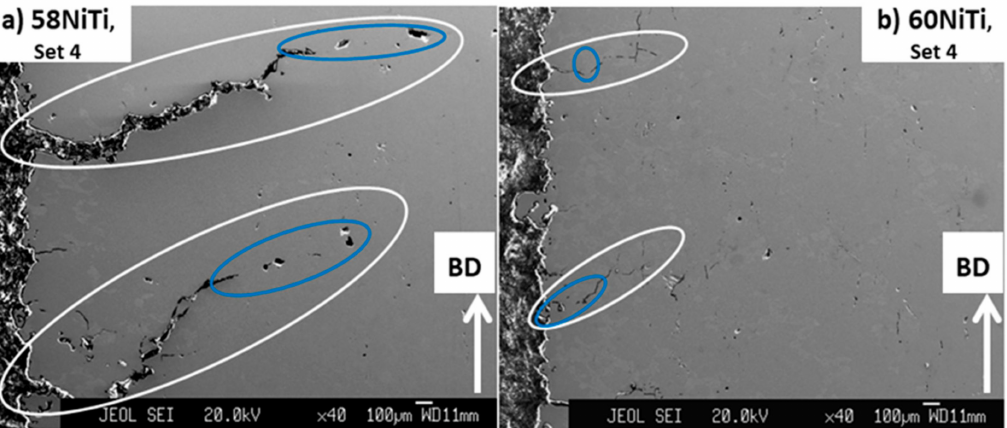
Figure 10. Images obtained from the cross-section of ( a ) 58NiTi and ( b ) 60NiTi parts processed from parts printed by processing set 4 having an energy input of 39.68 J/mm 3 . The white ovals show the total length of cracks, and the blue ones show the areas where the cracks were thought to be closed as a result of the applied HIP